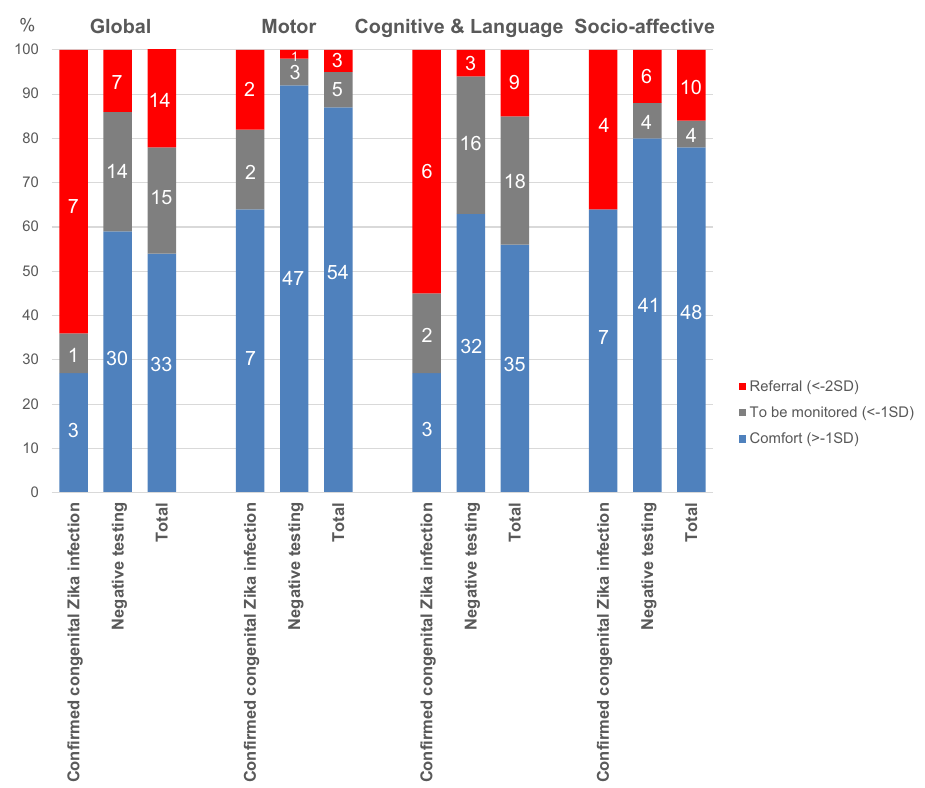
Fig. 4 Childhood development at 3 years of life. All children followed for in utero ZIKV exposure were recalled for a developmental evaluation using the Child Development Assessment Scale at 3 years of life (33 – 42 months, n = 62). Normal results are classi fi ed in the “ comfort ” or “ blue ” zone (> − 1 standard deviation [SD]). Intermediate results are classi fi ed in the “ to be monitored ” or “ gray ” zone ( − 2SD; − 1SD). Suspicion of delays is classi fi ed in the “ referral ” or “ red ” zone (< − 2SD). The motor, socio-emotional, and cognitive & language domains were evaluated using this scale. Results of these domains were synthesized in a global